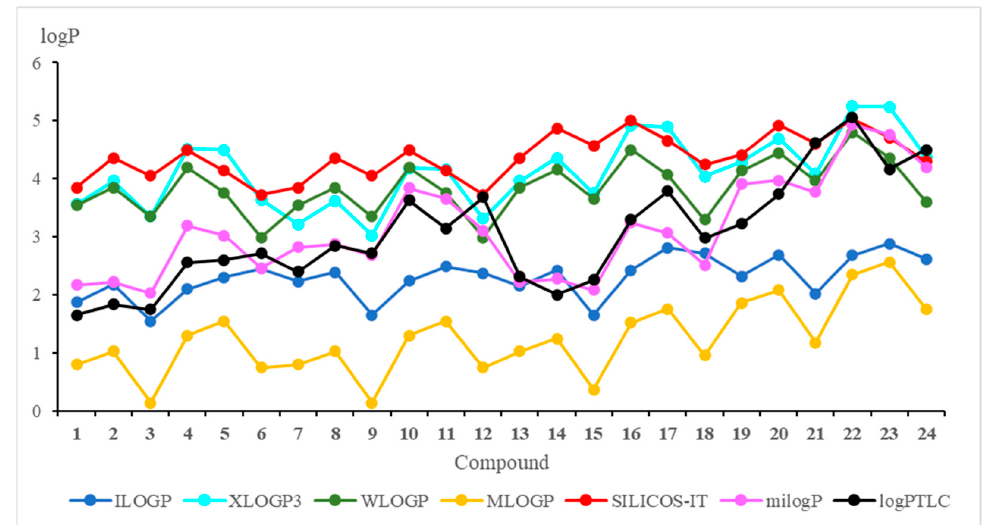
Figure 3. Theoretical and experimental values of the lipophilicity parameter (logP) for compounds 1 – 24 .